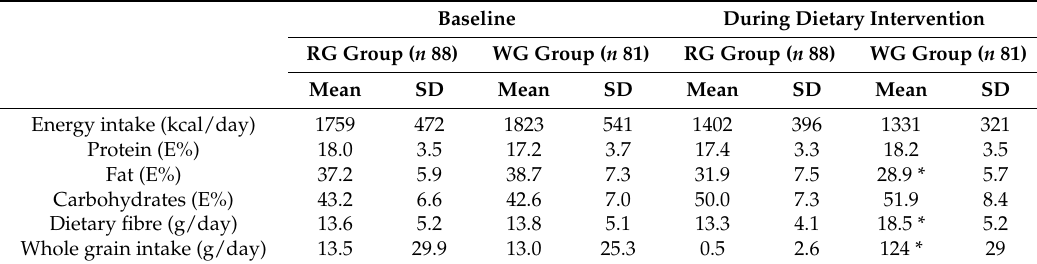
Table 2. Dietary intake data from 3-day food records of the participants at baseline (visit 1) and during the last week of the dietary intervention (visit 4) in the whole-grain (WG) and refined-grain (RG) groups (mean values and standard deviations (SD)).